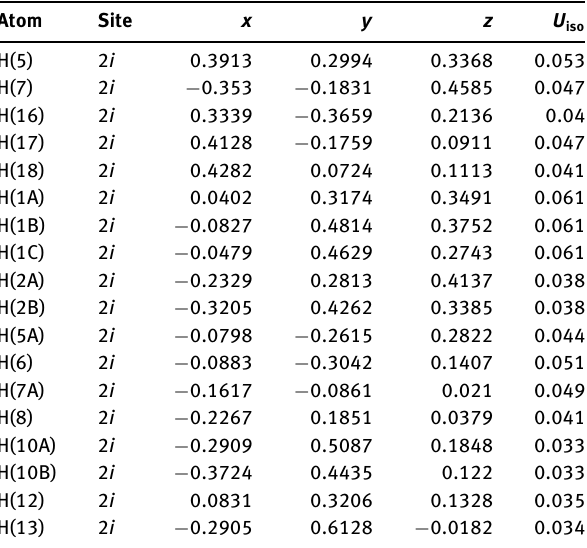
Table 2: Fractional atomic coordinates and isotropic or equivalent isotropic displacement parameters (Å 2 ).